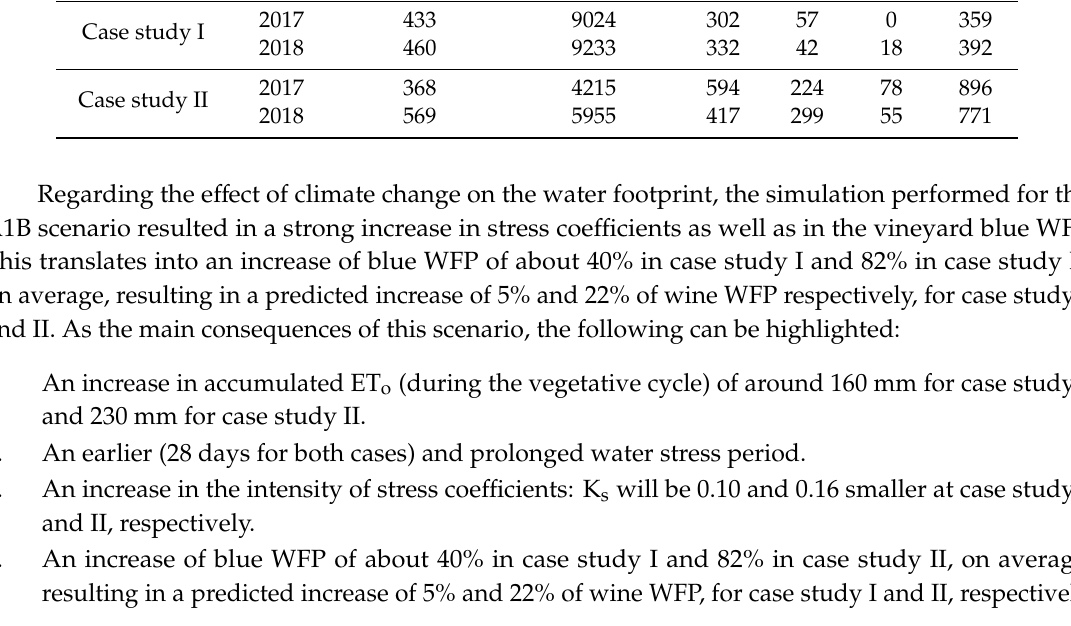
Table 3. Vineyard direct water footprint components for case study I and case study II, in 2017 and 2018. Accumulated Year ET Act